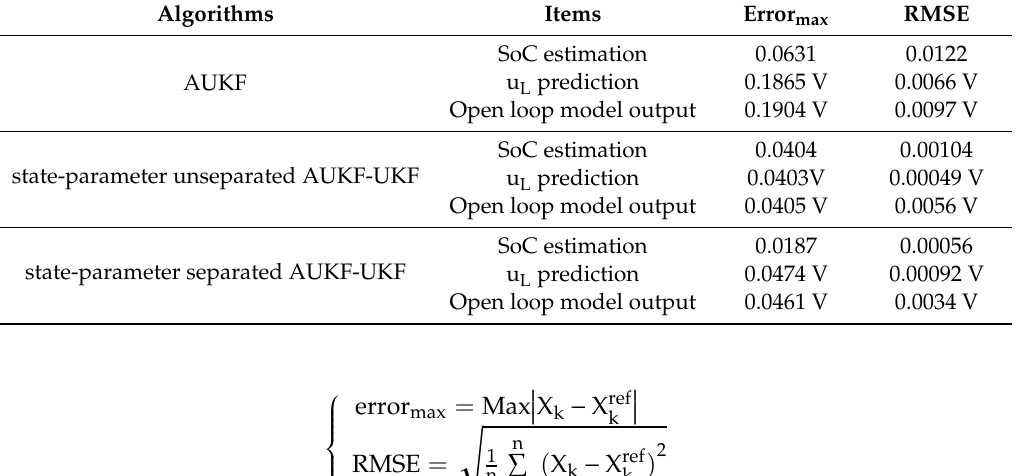
Table 4. Error analysis of di ff erent algorithms under HPPC